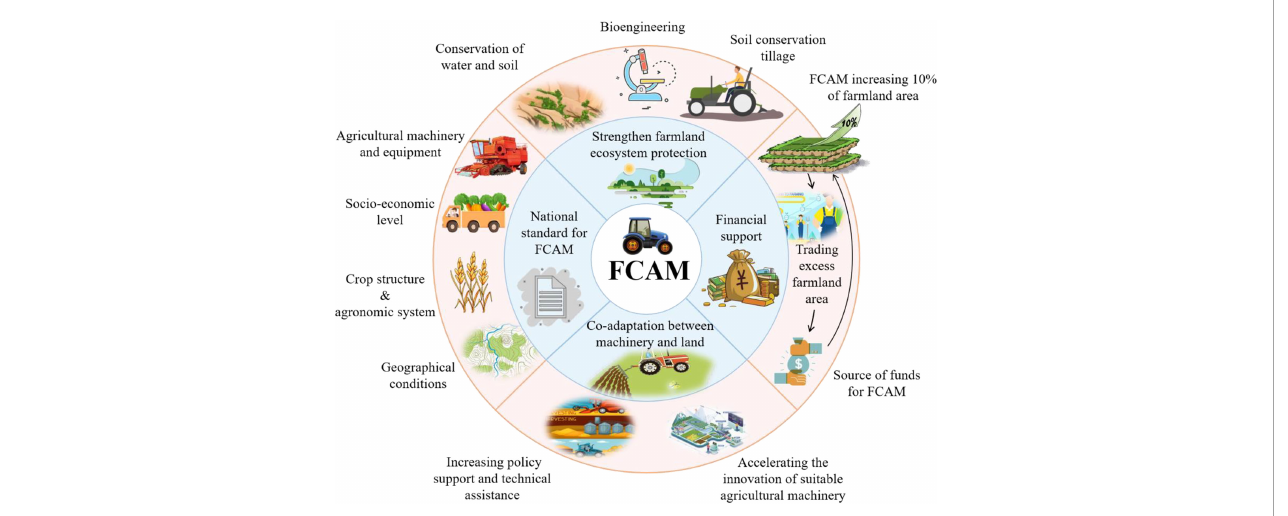
FIGURE 8 Alternative strategies for FCAM schemes. FCAM, farmland consolidation suitable for agricultural machinery.